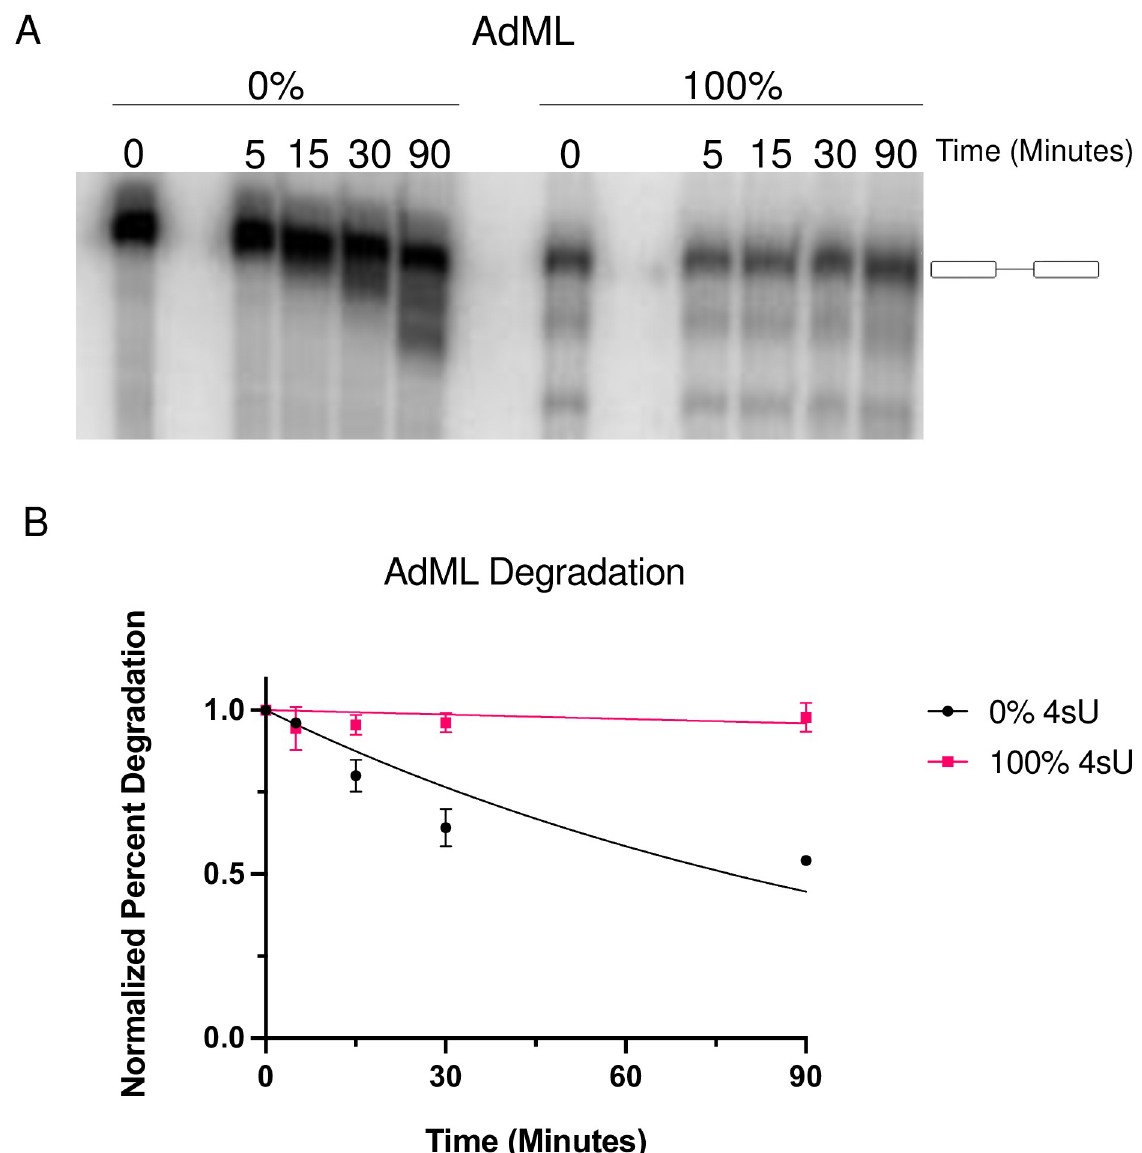
Fig 2. In vitro degradation assay of AdML minigene. (A) Representative autoradiograph of degradation time-course for unmodified and fully modified 4sU AdML pre-mRNA. Time ‘0’ represents input RNA. Full-length input RNA is defined by the cartoon to the right of the gel. (B) Quantitation of the data shown in (A). First order decay regression of time course data was used for rate determination and statistical analysis.